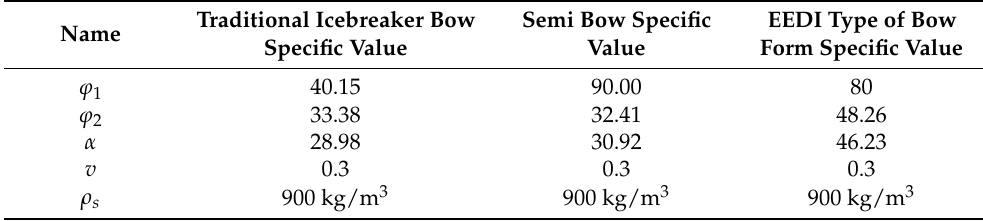
Table 2. Calculation parameters of different bow forms (Linqvist method and FSICR